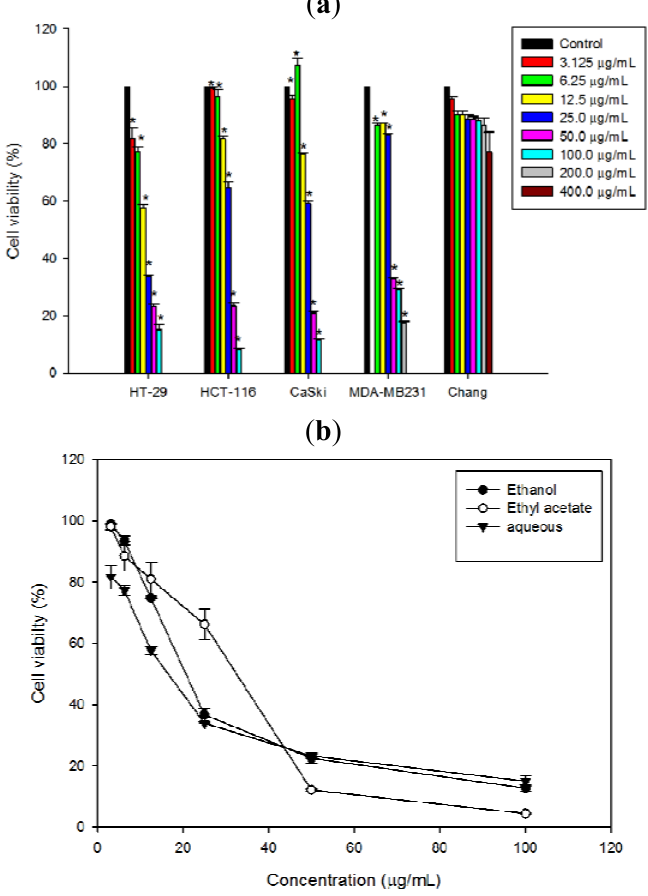
Figure 1. The cytotoxicity of NRAF extract and fractions against selected cancer cell lines at 72 h. ( a ) represented the effect of NRAF on the viability of HT-29, HCT-116, Ca Ski, MDA-MB-231 and Chang liver cells. ( b ) Represented the cytotoxicity of N. ramboutan-ake rind ethanol extract (NREE), ethyl acetate fraction (NREAF) and aqueous fraction (NRAF) against HT-29 cell lines. The data expressed as mean ± S.E. of three independent experiments (n = 9). Asterisks indicate significantly different value from control ( * p < 0.05).